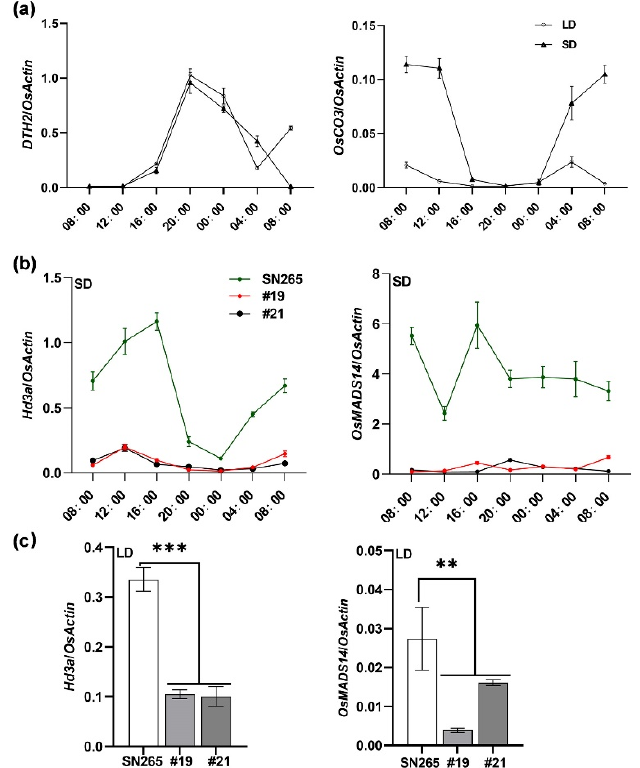
Figure 2. Expression analysis in SN265 and dth2 - osco3 lines via qRT-PCR under SD and LD conditions in Guangzhou. Under SD, leaves of 53-d-old plants were used for the expression analysis. Under LD, leaves of 80-d-old plants were used for the expression analysis. ( a ) expression of DTH2 and OsCO3 in SN265 under SD and LD, respectively. ( b , c ) expression of Hd3a and OsMADS14 in SN265 and dth2 - osco3 lines under SD and LD, respectively. Error bars represent SD of three biological replicates. Values are means ± SD. **, p < 0.01. ***, p < 0.001.